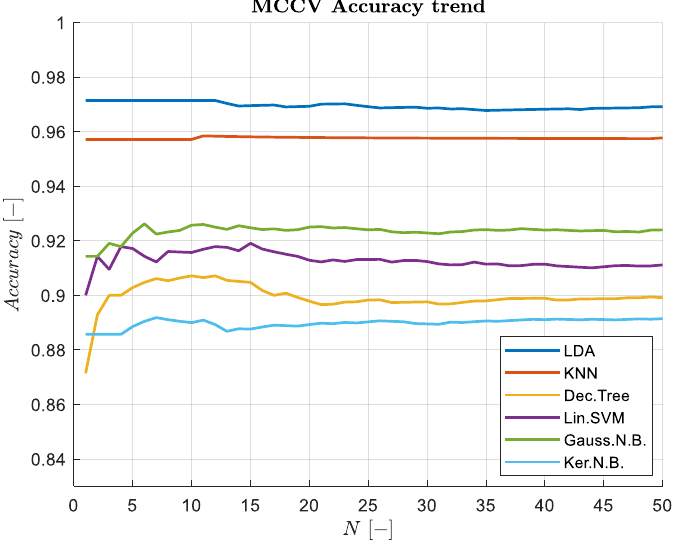
Figure 3. The trend of the accuracy values calculated with MCCV on the merged information of NI α and NI m as the number of iterations N grows.